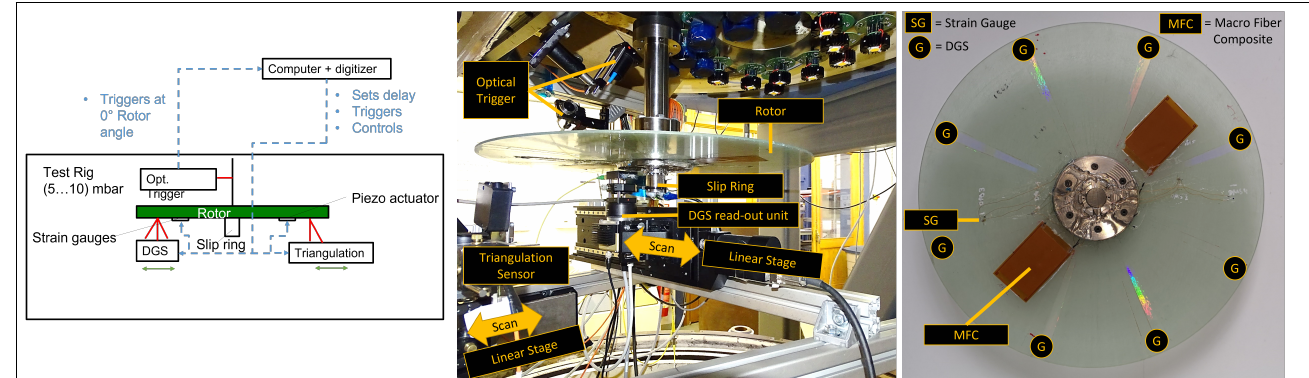
Figure 5. Left : functional sketch of setup. Center : photograph of the setup. Right : photograph of the